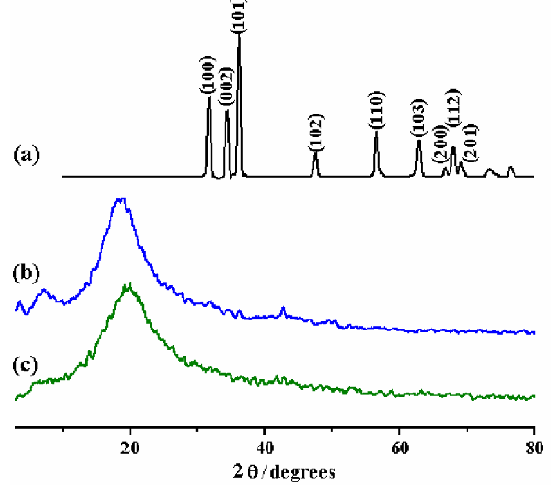
Figure 5. The XRD pattern of ZnO powder (a), ZnO-PCEMA-Br-2 (b) and ZnO-PCEMA- b -PEGMA-Br-2 (c) nanoparticles.